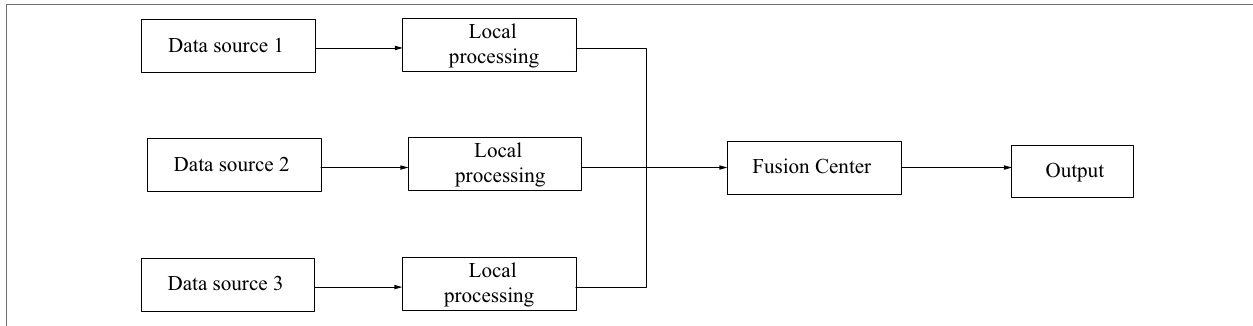
FIGURE 4 | Distributed architecture of information fusion.